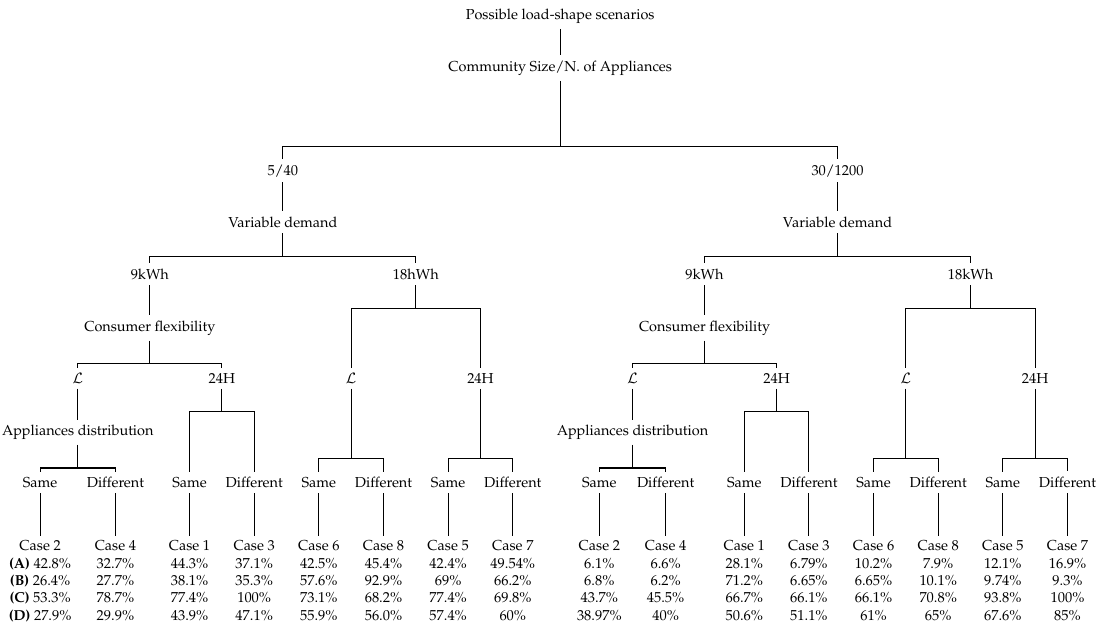
Figure 11. CC results (in %) after applying different strategies (Section 3.3) performed under SA: Round-Robin ( A ), Randomly Round-Robin ( B ), “having the first consumer always the same” ( C ) and randomly ( D